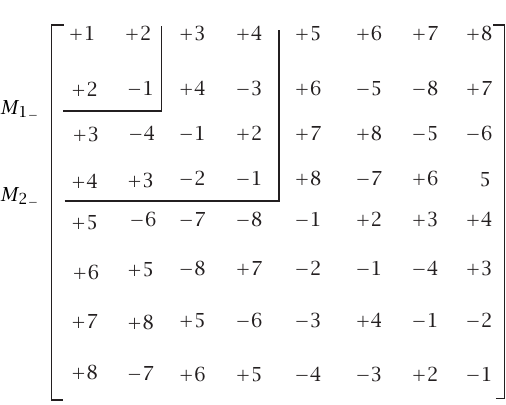
Figure 2.1 . The ⊗ -matrix M 3 (E 8 ) = (m